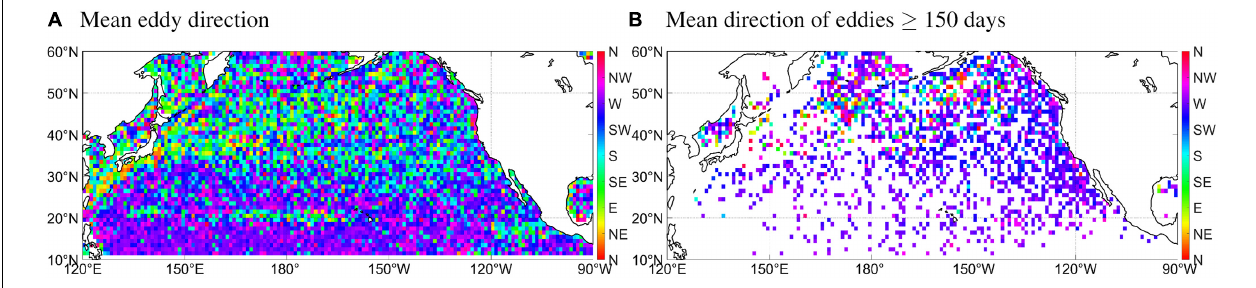
FIGURE 3 | Mean eddy direction defined as the azimuth of eddy termination location relative to the generation location, averaged within 1 ◦ × 1 ◦ grid cells, organized by the generation location. (A) Shows mean eddy direction across all eddies in a grid cell, and (B) show mean direction across eddies persisting for longer than 150 days.